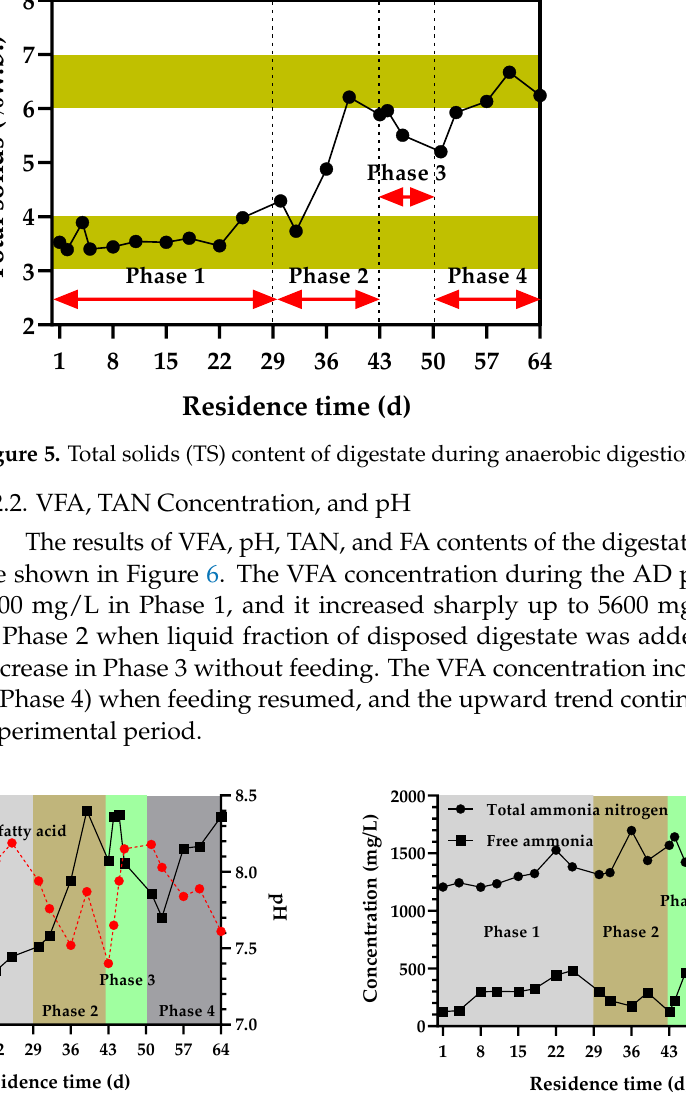
Figure 4. Weekly cumulative biogas production and methane concentration.